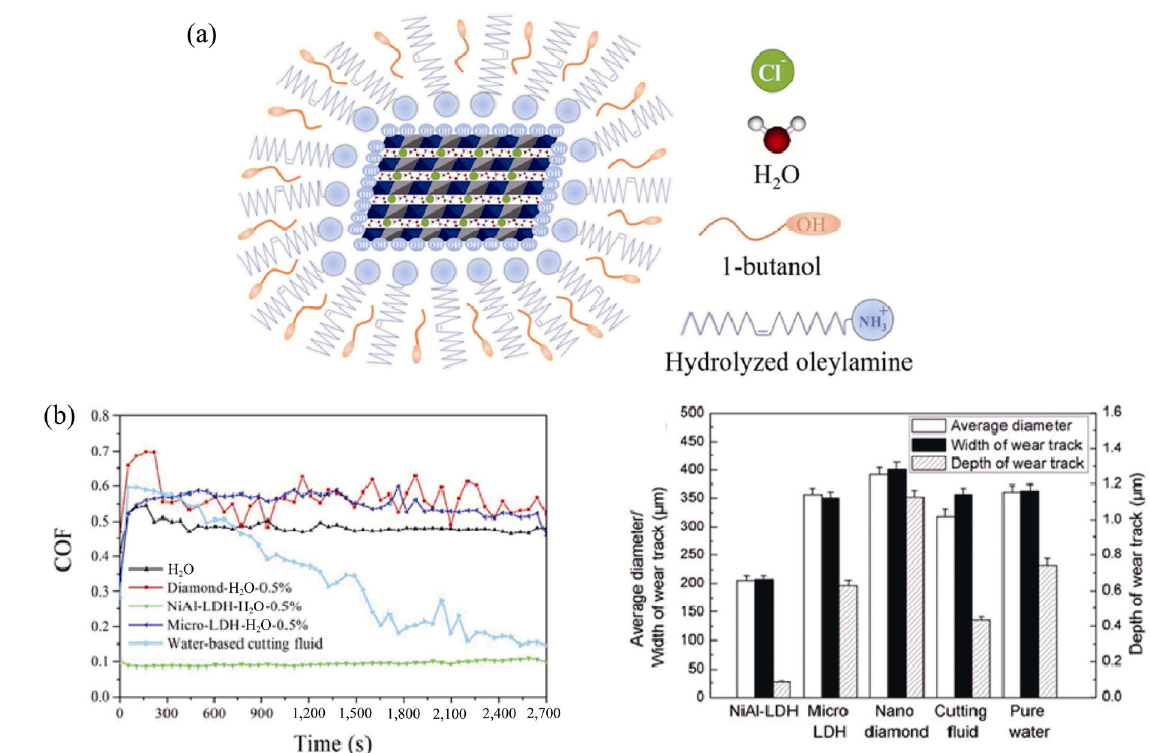
Fig. 9 (a) Schematic model of NiAl–LDH/OAm. (b) COF and wear condition of five lubricant samples, which contain diamond nanoparticles, NiAl–LDH nanoplatelets, LDH microplatelets, water-based cutting fluid, and pure water. Reproduced with permission from Ref. [72], © American Chemical Society 2016.